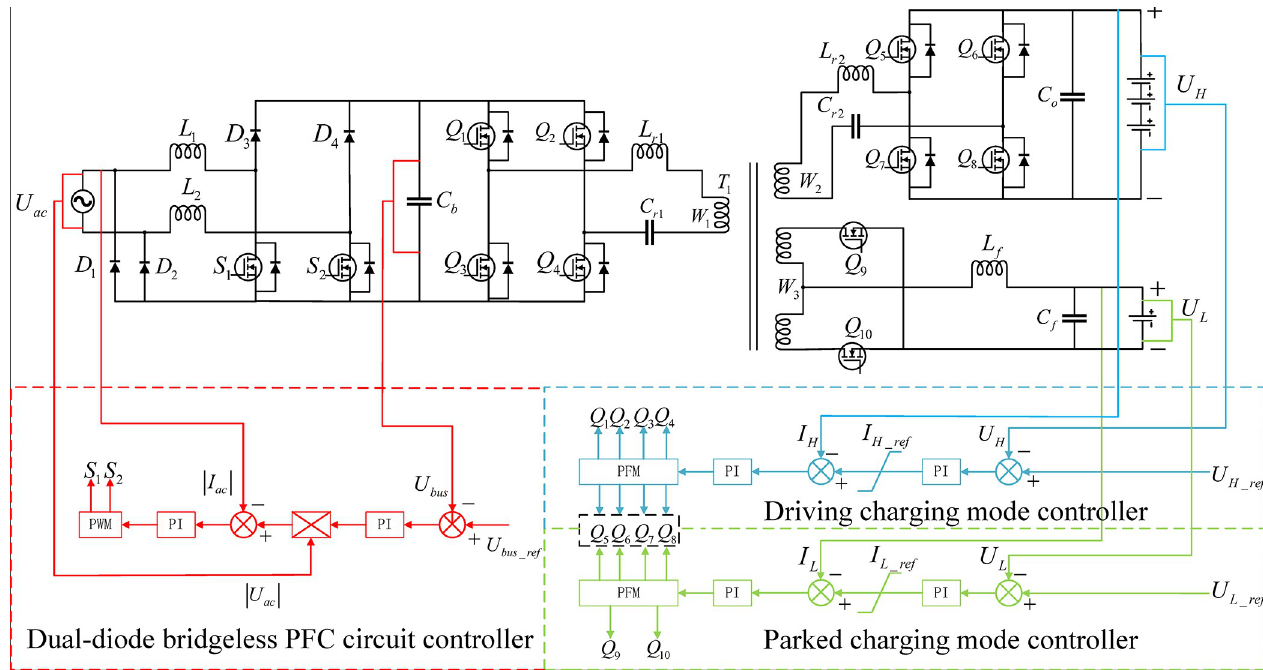
Fig 10. System control